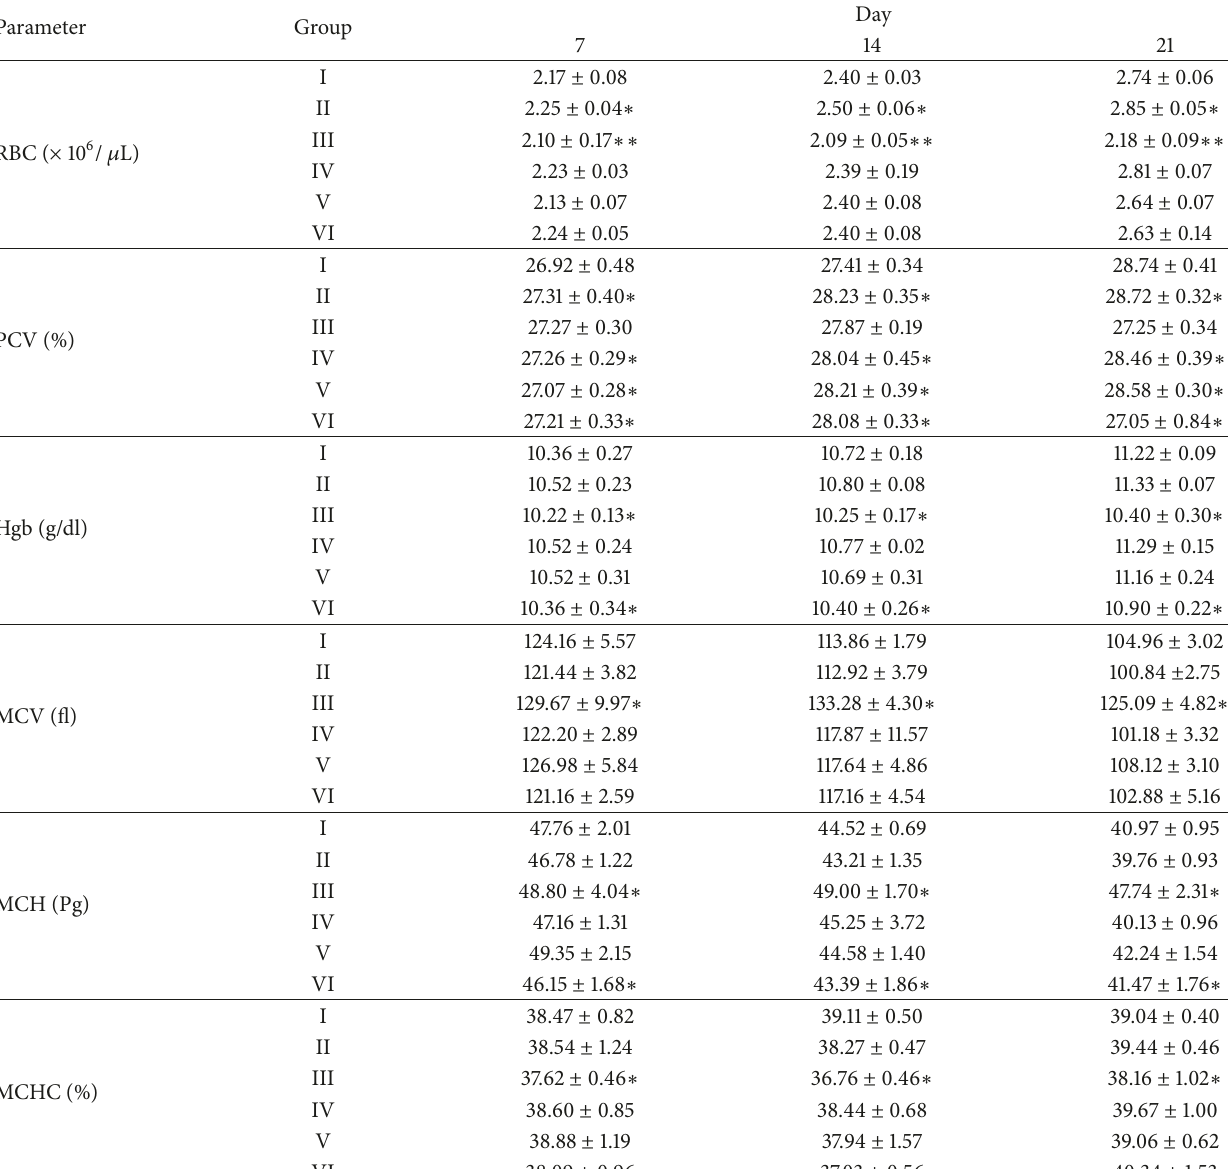
Table 6: Effects of 5% SAP on the haematological profile (RBC, PCV, Hgb, MCV, MCH, and MCHC) of broiler chickens fed a diet naturally contaminated with AF at 7, 14, and 21 days of